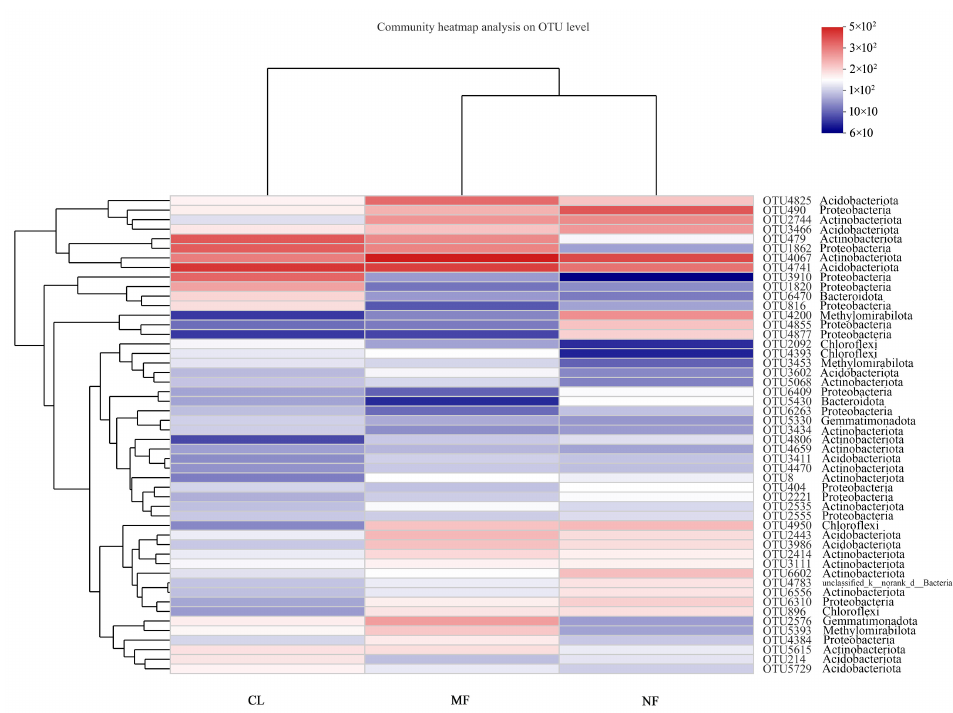
Figure 3. A heatmap diagram of the 50 dominant OTUs in the three land-use types. NF—natural secondary forest; MF—managed forest; CL—cropland.